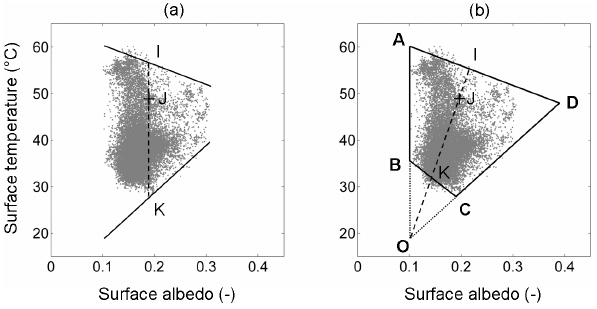
Fig. 2. EF is computed as IJ/IK in S-SEBI (a) and SEB-1S (b) . Underlying grey points correspond to data on 27 April